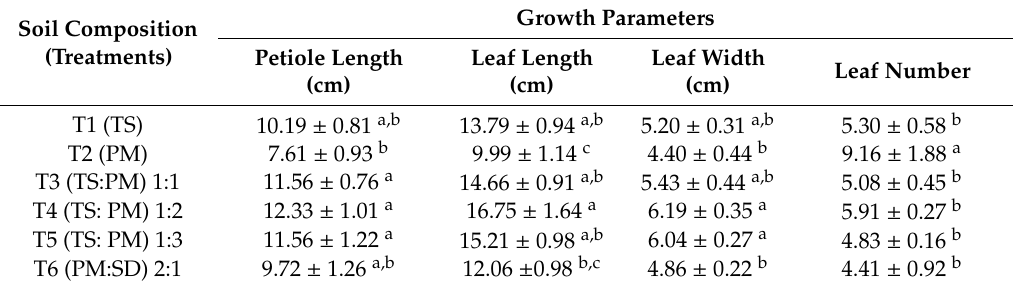
Duncan's multiple range test (DMRT), n = 12. Table 6. E ff ect of di ff erent composition of soil media on the growth of plantlets in the greenhouse. Table 6. Effect of different composition of soil media on the growth of plantlets in the greenhouse. Soil Soil Composition